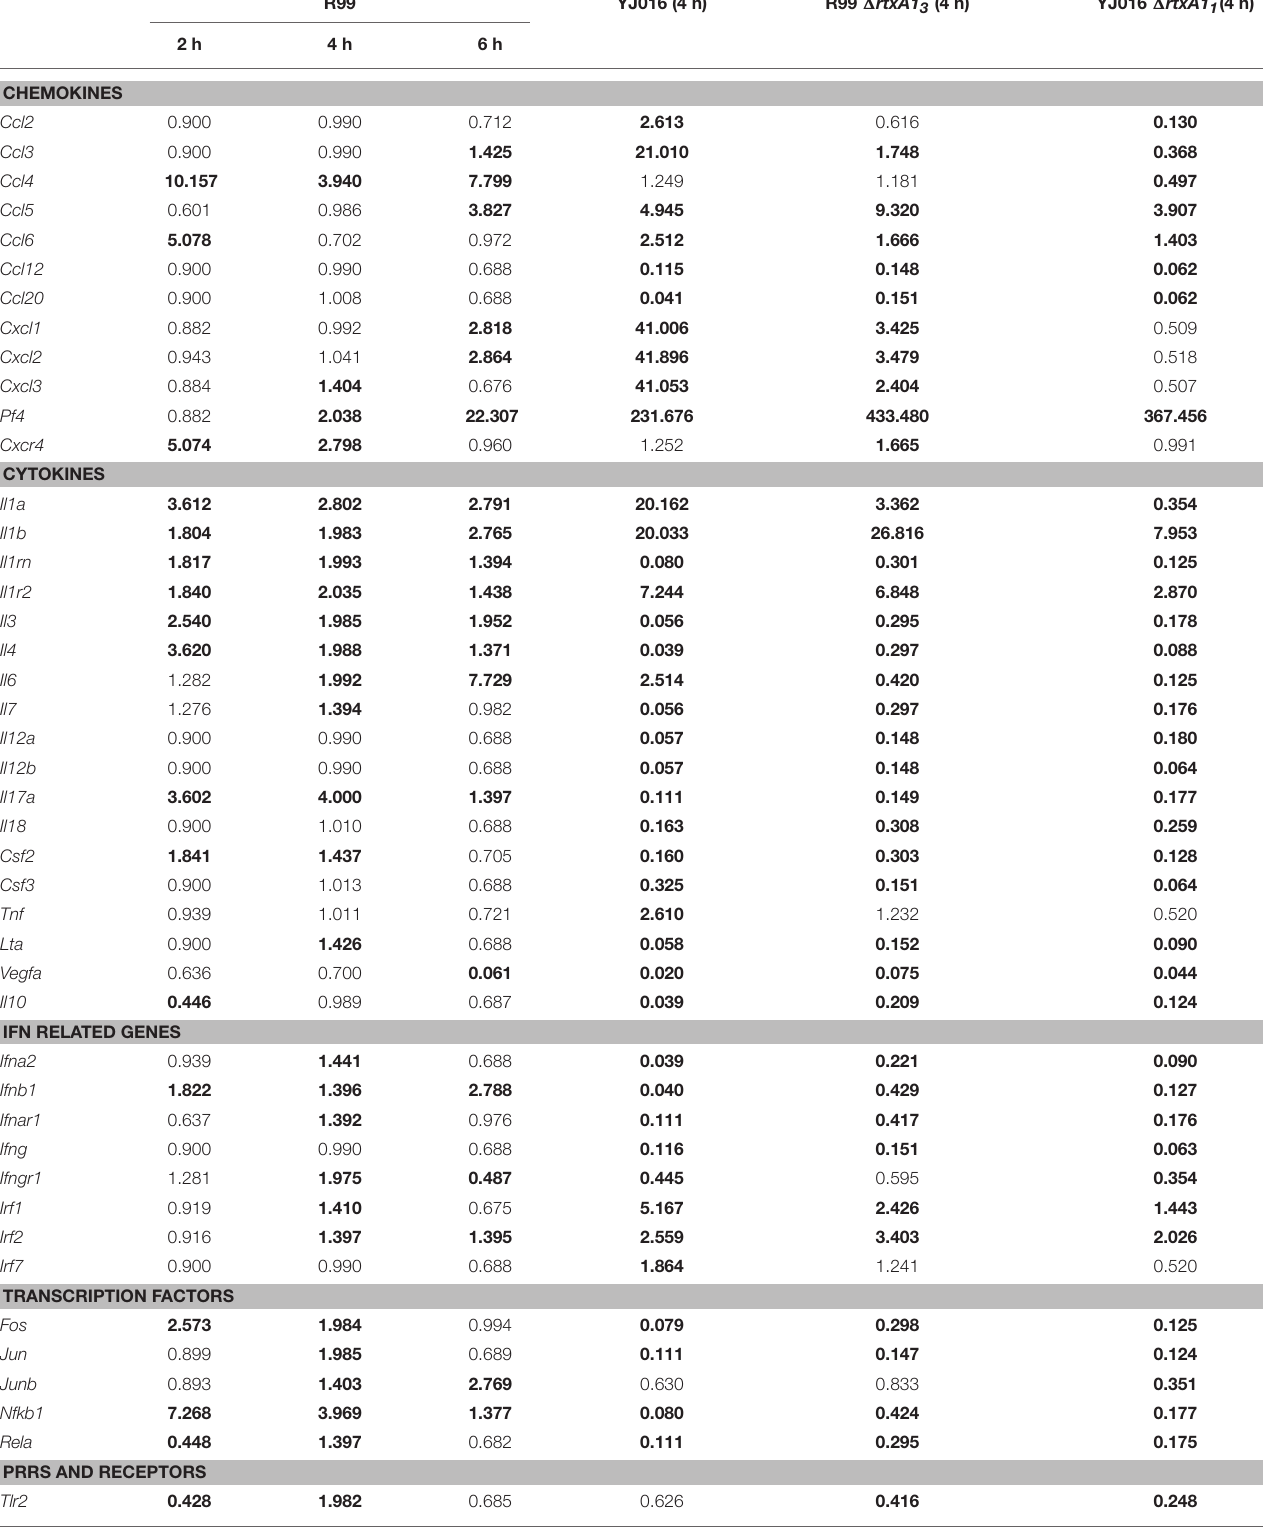
TABLE 2 | Fold change value of genes when compared with uninfected